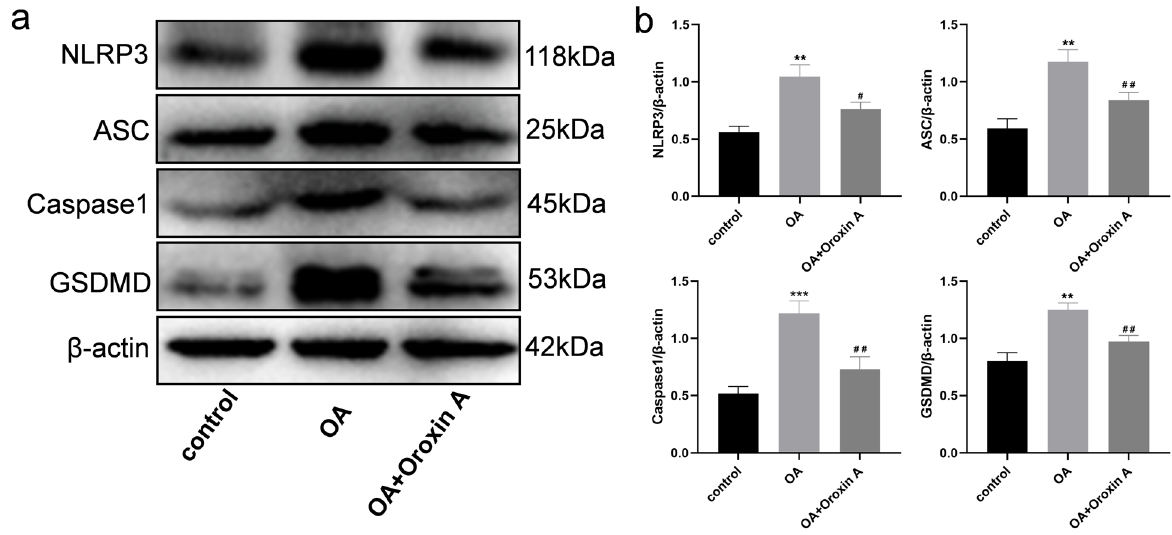
Figure 4. The effects of Oroxin A on pyroptosis-related protein expression in the OA-induced A549 cell injury. The level of NLRP3, ASC, Caspase-1 and GSDMD in the OA group was significantly higher than that in the control group, but the level of NLRP3, ASC, Caspase-1 and GSDMD in the OA+Oroxin A group was significantly lower than that in the OA group (a, b). All data were expressed as mean ± SEM. Statistical significance was analyzed by Student’s t test. ** p <0.01, *** p <0.001 compared with control group, # p <0.05, ## p <0.01 compared with OA group, n=3 in each